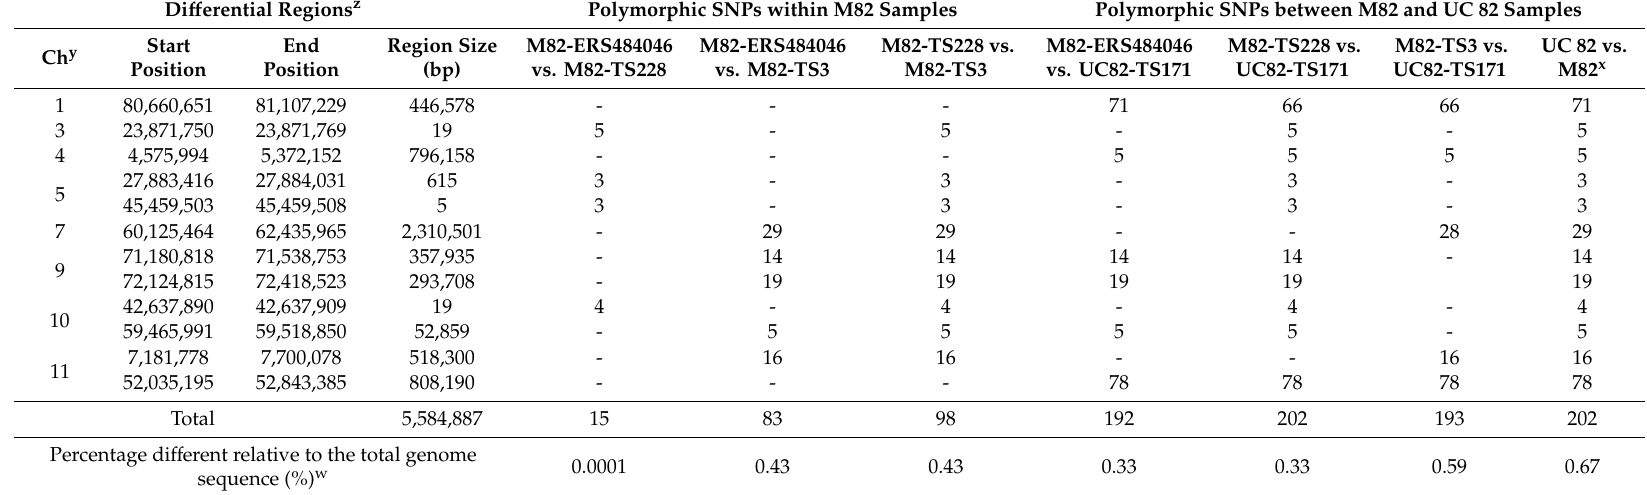
Table 3. Genomic regions carrying polymorphic SNPs within ‘M82’ and between ‘UC 82’ and ‘M82’ samples based on the whole genome sequence alignment and SNP calling